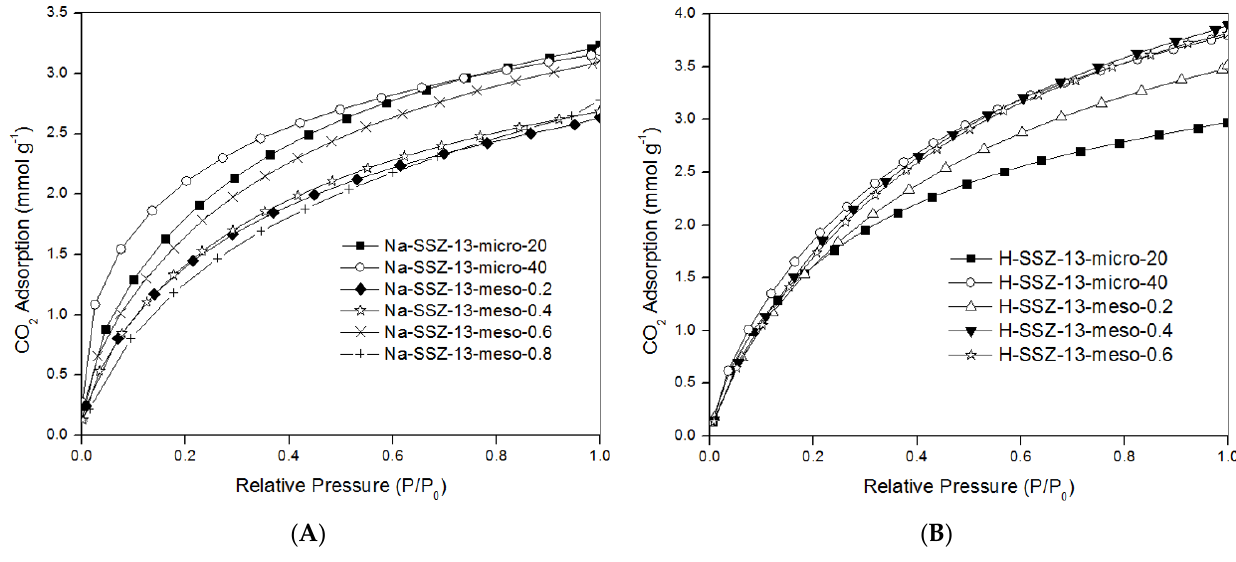
Figure 7. ( A ) CO 2 adsorption isotherms for Na ‐ SSZ ‐ 13 materials; ( B ) CO 2 adsorption isotherms for H ‐ SSZ ‐ 13 materials. Table 3. CO 2 adsorption capacity and rate and the Langmuir isotherm parameters for microporous and mesoporous materials.